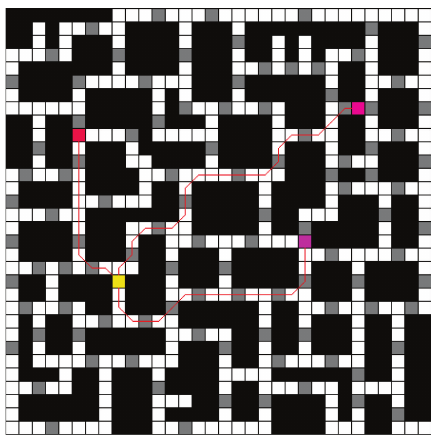
Figure 11: Explore and trap strategy.